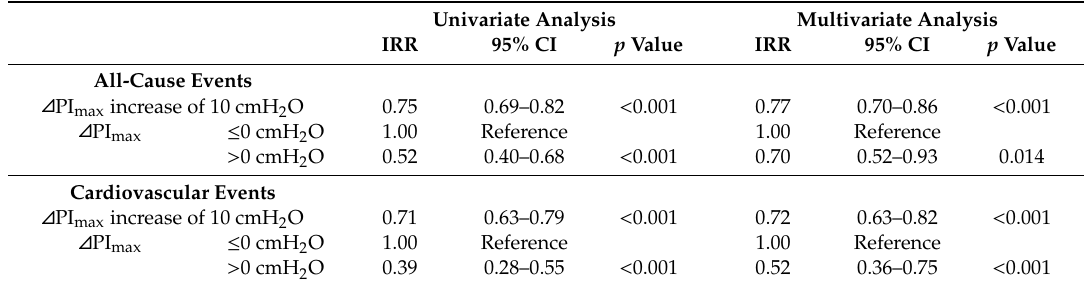
Table 2. Poisson regression models of changes in PI max for adverse clinical